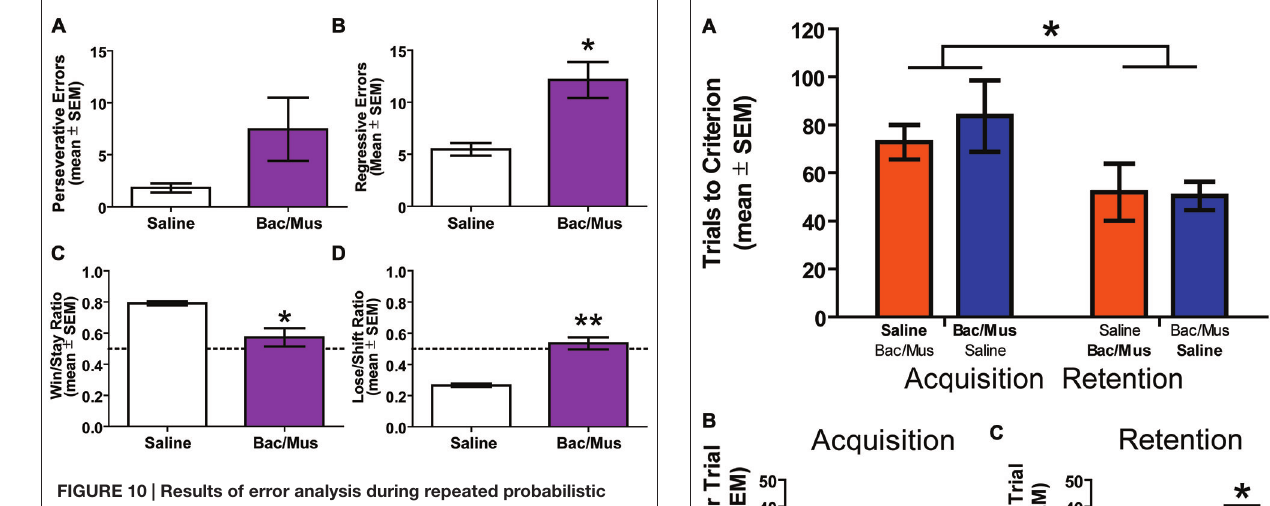
FIGURE 10 | Results of error analysis during repeated probabilistic reversal learning. (A) LHb inactivation did not cause a significant increase in perseveration during serial reversals. (B) Regressive errors were significantly increased following LHb inactivation. (C) LHb inactivation caused a significant decrease in win-stay ratio. (D) There was also a significant increase in lose-shift ratio following LHb inactivation. The dashed line represents chance choices. ∗ p < 0.05, ∗∗ p < 0.01.